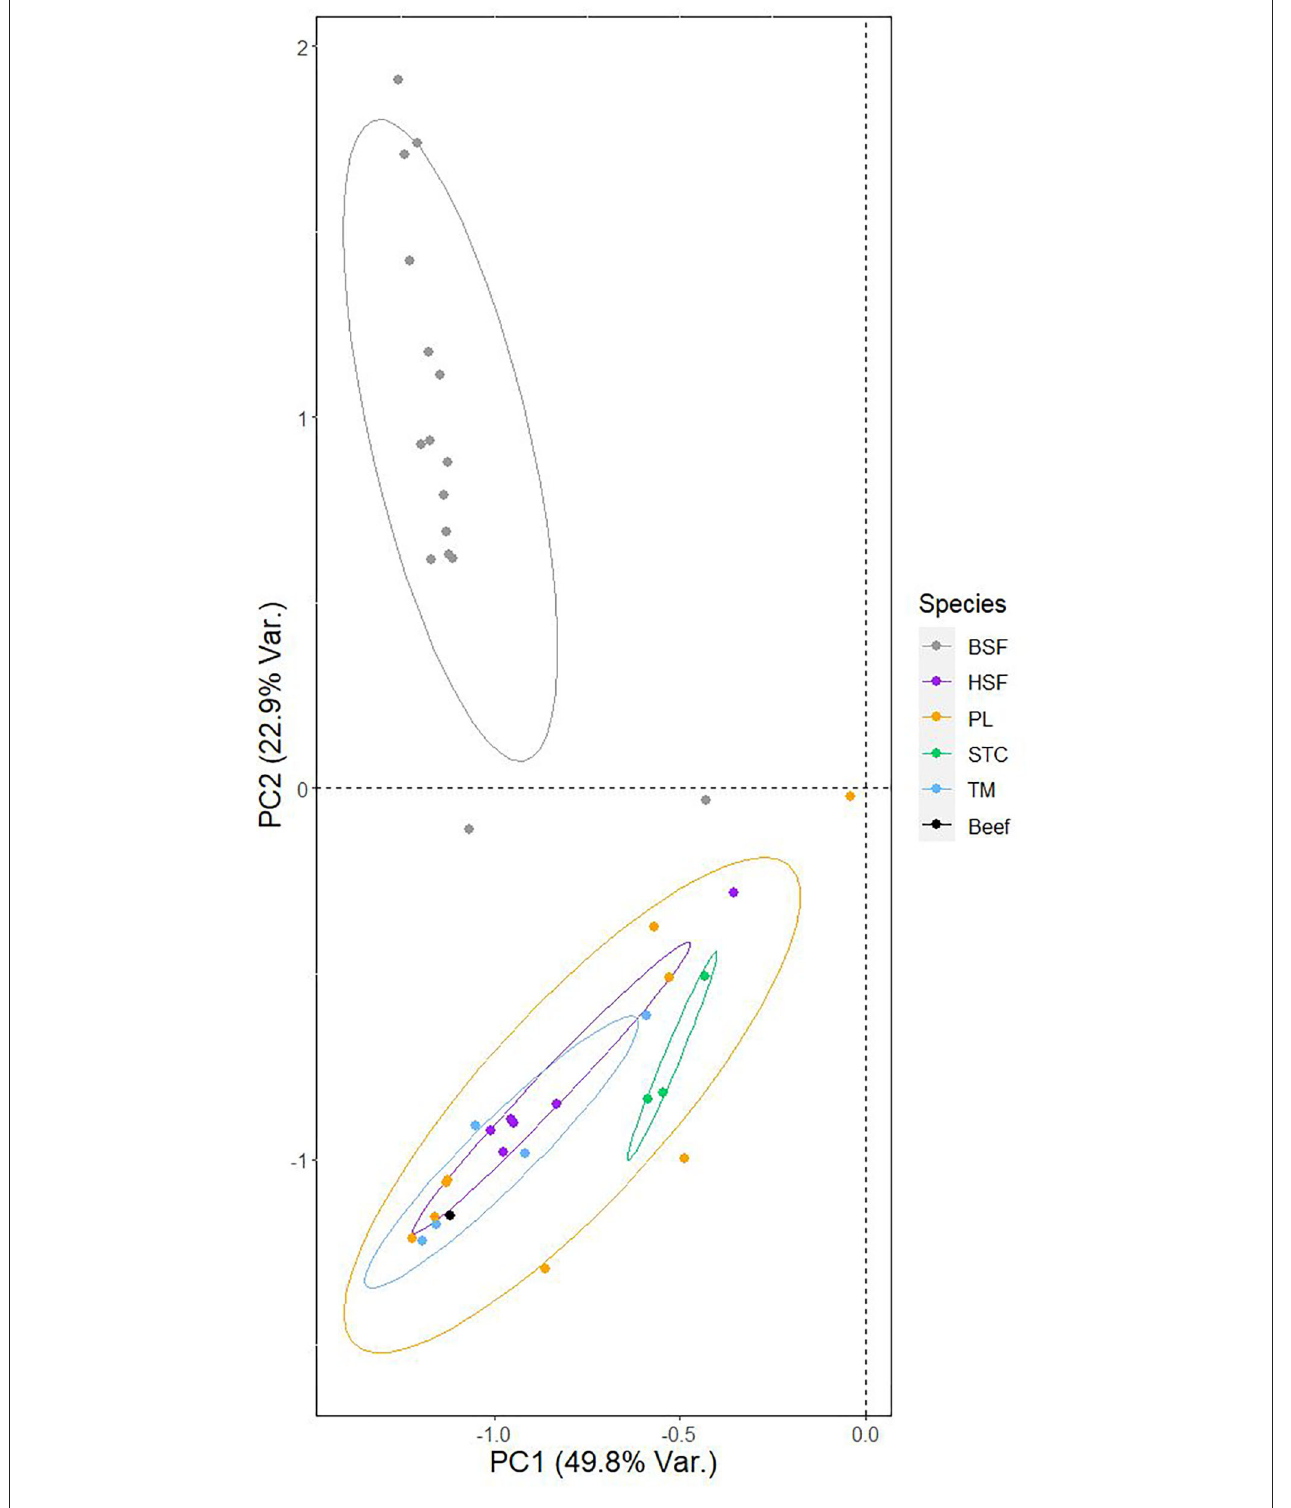
FIGURE 2 | Principal component analysis of the fatty acid profiles of the five analyzed species of edible insect. The relationship between the two primary principal components and individual datapoints, corresponding to a fatty acid profile of an individual species presented either in the literature or analyzed in this study, is shown. Points are colored based on the species to which they belong, as are the ellipses surrounding each species’ datapoints. Superimposed onto the plot is the position of the fatty acid profile of beef, obtained from van Huis et al. (24), relative to the two primary principle components.